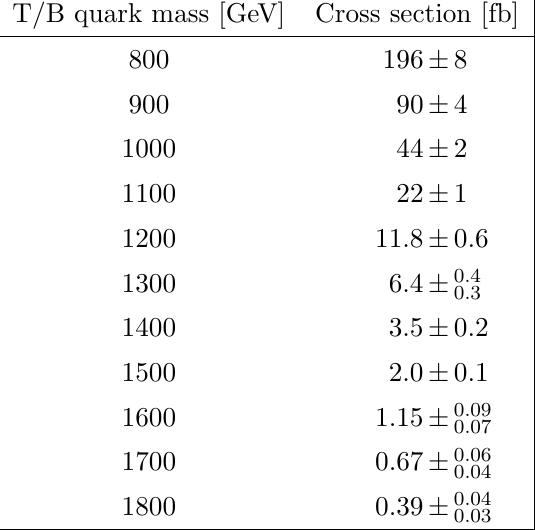
Table 1 . Theoretical cross sections of TT or BB production, for various masses, assuming a width of 10 GeV at each mass point. The cross section uncertainties include contributions from uncertainties in the PDFs and uncertainties estimated by varying factorization and renormalization scales by a factor of